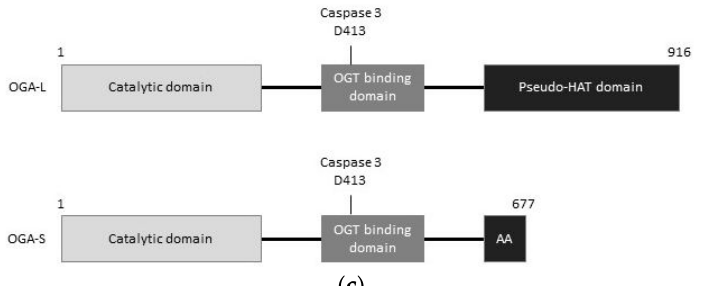
Figure 2. The hexosamine biosynthetic pathway (HBP) and the two key enzymes: O-GlcNAc transferase (OGT) as a writer and O-GlcNAcase (OGA) as an eraser with their isoform structures. ( a ) The donor for O-GlcNAcylation, UDP-GlcNAc is synthesized when glucose enters the HBP. Here, glutamine serves as a nitrogen donor and AcCoA serves as an acetyl donor. More detailed pathway descriptions can be found in the text [27,29,35,36]. ( b ) Three OGT isoforms are known: ncOGT, mOGT, and sOGT. They are generated by alternative splicing and they largely differ in the number of tetratricopeptide repeats (TPRs) at the N-terminus, which is necessary for protein–protein interactions. The catalytic domains I and II are responsible for binding to UDP-GlcNAc and transferring the O-GlcNAc group to serine or threonine residues on target proteins. The OGT enzyme can, for example, be recruited to the cell membrane via the PIP-binding activity domain (PPO) domain as characterized in response to insulin receptor activation by insulin [28,29,37,38]. ( c ) There are two known isoforms of OGA: a long (OGA-L) and a short (OGA-S). Both share a catalytic domain and an OGT binding domain. The long isoform contains a pseudo-HAT domain, which is located at the C-terminus, and the short isoform has only a short amino acid stretch with less known function. Both isoforms have a cleavage site for caspase 3 at position D413, which is associated with apoptosis [28,29,39].